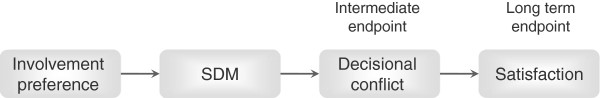
Conceptual model of central shared decision-making related constructs.